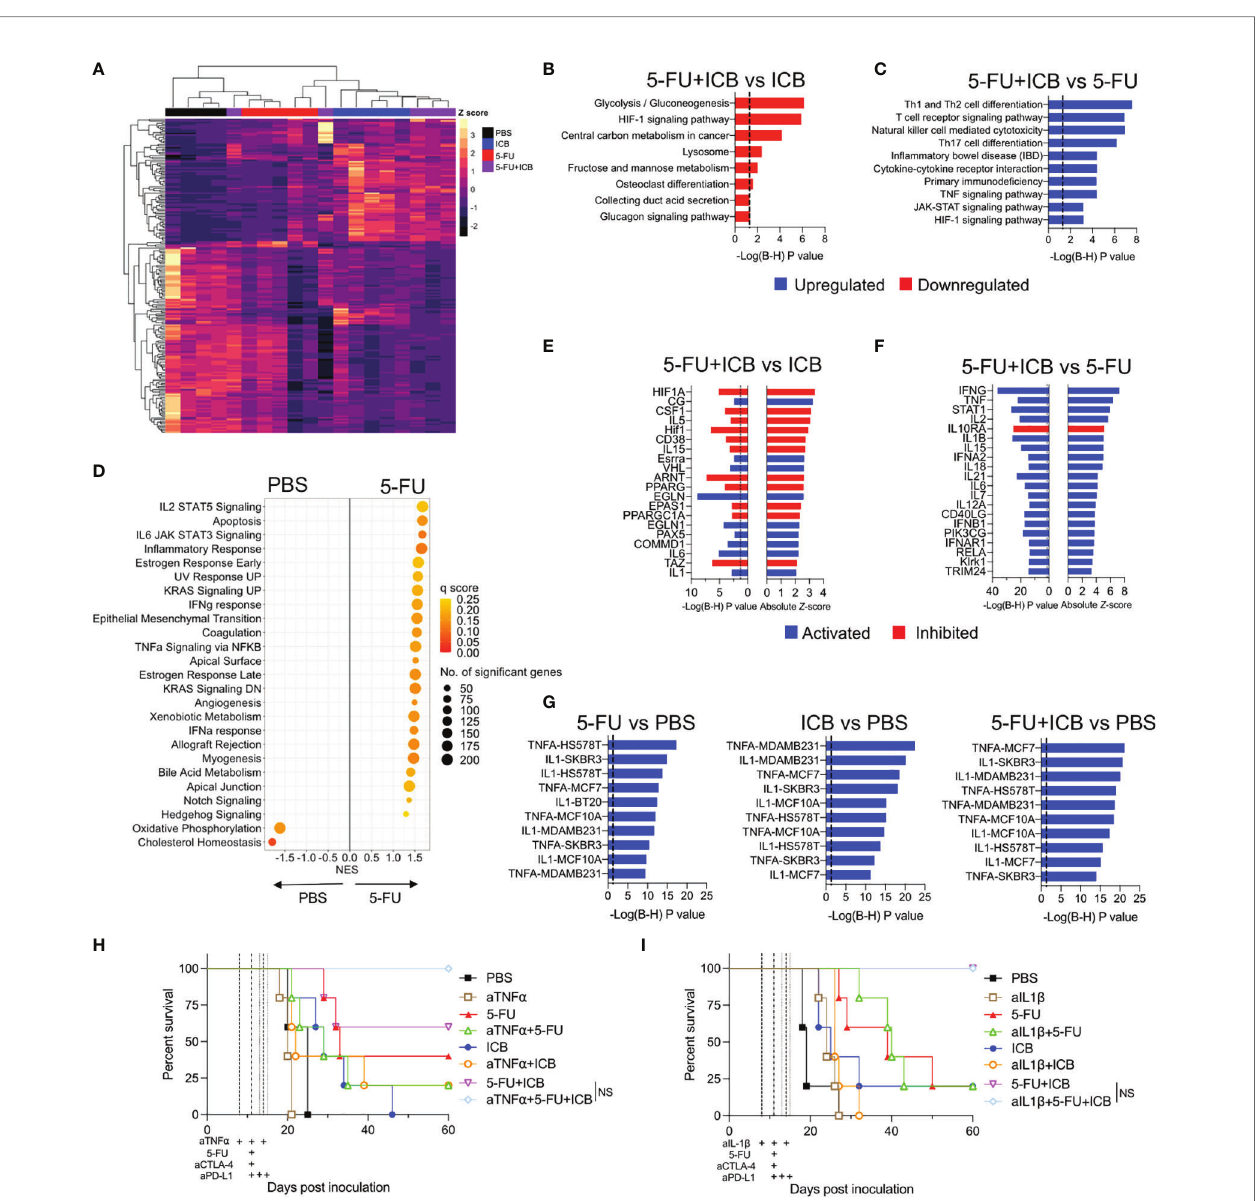
FIGURE 4 | 5-FU-based chemo-immunotherapy upregulates immune-associated pathways and downregulates hypoxia and glycolysis pathways. (A) Unsupervised hierarchical clustering of the top 200 differentially expressed genes from 5-FU+ICB treatment groups. (B) Downregulated KEGG pathways in 5-FU+ICB compared to ICB treated tumors. (C) Top 10 upregulated KEGG pathways in 5-FU+ICB when compared 5-FU. Multiple comparisons corrected using Bonferonni-Hochberg method. Signi fi cance denoted by P < 0.05. (D) GSEA displaying top hallmark gene sets signi fi cantly (q < 0.25) enriched in 5-FU compared to PBS. A positive normalized enrichment score (NES) indicates that speci fi c gene set is enriched in a 5-FU treated tumor compared to PBS. (E, F) Graphs displaying the top 20 upstream regulators in 5-FU+ICB compared to ICB (E) or 5-FU (F) treated tumors. Upstream regulators are colored by the activation Z -score. Regulators with a Z- score ≥ 2 are activated and are displayed in blue. Regulators with a Z -score ≤ -2 are inhibited and are displayed in red. (G) Top 10 most signi fi cantly upregulated LINCS L1000 gene signatures in 5-FU, ICB and 5-FU+ICB in comparison to PBS treated tumors. Multiple comparisons corrected using Bonferonni ‐ Hochberg method. Signi fi cance denoted by P < 0.05. (H – I) Survival curves of AB1 ‐ HA tumor bearing mice treated with anti- TNF a (H) or anti-IL-1 b (I) blocking antibodies, 5-FU, ICB or 5-FU+ICB therapies. Data represents one experiment (n = 5 per group). Mantel ‐ Cox survival test. B-H, Bonferonni-